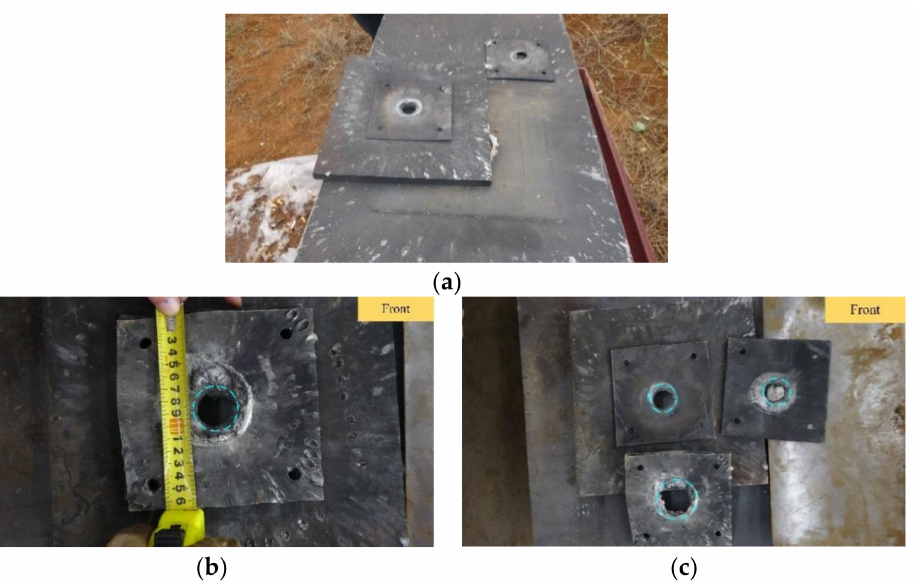
Figure 9. Penetration target test results. ( a ) Image of the recovered steel target; ( b ) measurement of the jet’s perforation size; and ( c ) the results of the steel target penetration